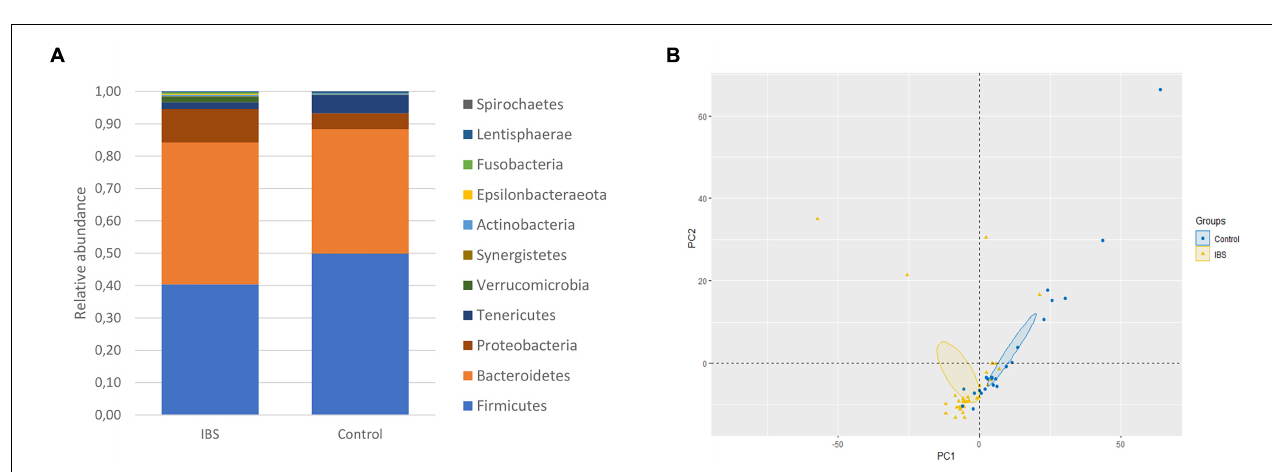
FIGURE 1 | Comparison of alpha diversity indices of the fecal bacterial microbiota between controls (E–H) and IBS-C subjects (A–D) according to Blastocystis carriage. (A,E) Chao 1, (B,F) observed number of OTUs, (C,G) Shannon diversity, and (D,H) Simpson’s index. Significant (or close to significance) p -values were reported on boxplots. IBS/B-: Blastocystis -negative IBS patients; IBS/B + : Blastocystis -positive IBS patients; Control/B-: Blastocystis -negative control subjects; Control/B + : Blastocystis -positive control subjects.